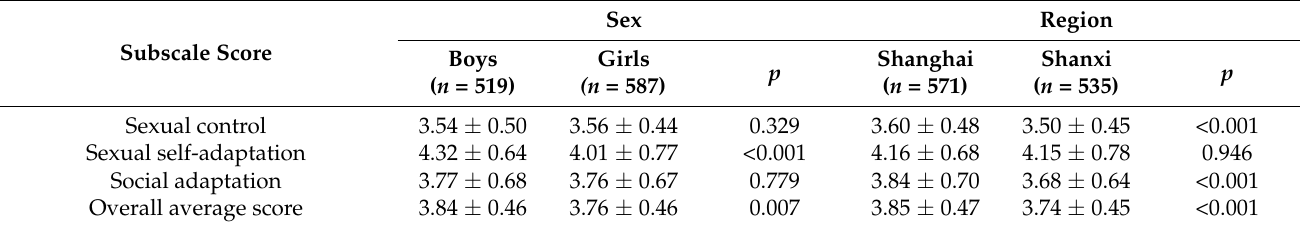
Table 2. Average score for each factor of sexual adaptation based on sex and region.